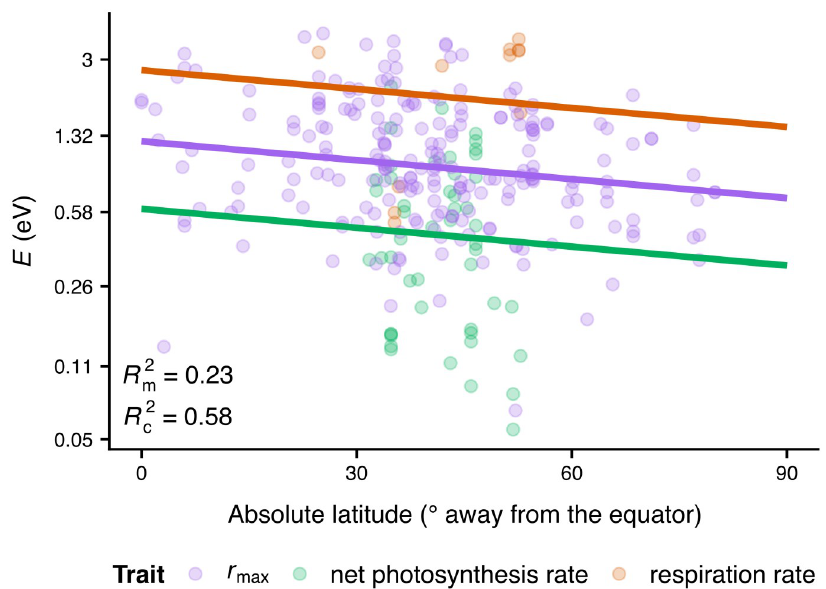
Fig 7. E values weakly decrease with absolute latitude. 23% of the variance is explained by latitude and trait identity, which increases to 58% if species identity is added as a random effect on the intercept. Note that values on the vertical axis increase exponentially. The data underlying this figure are available at https://doi.org/10.6084/m9.figshare. 12816140.v1.